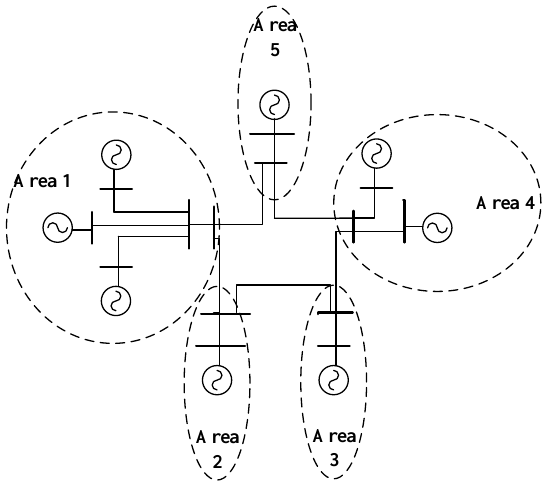
Figure 3. Circuit diagram of a 5-area ring network.